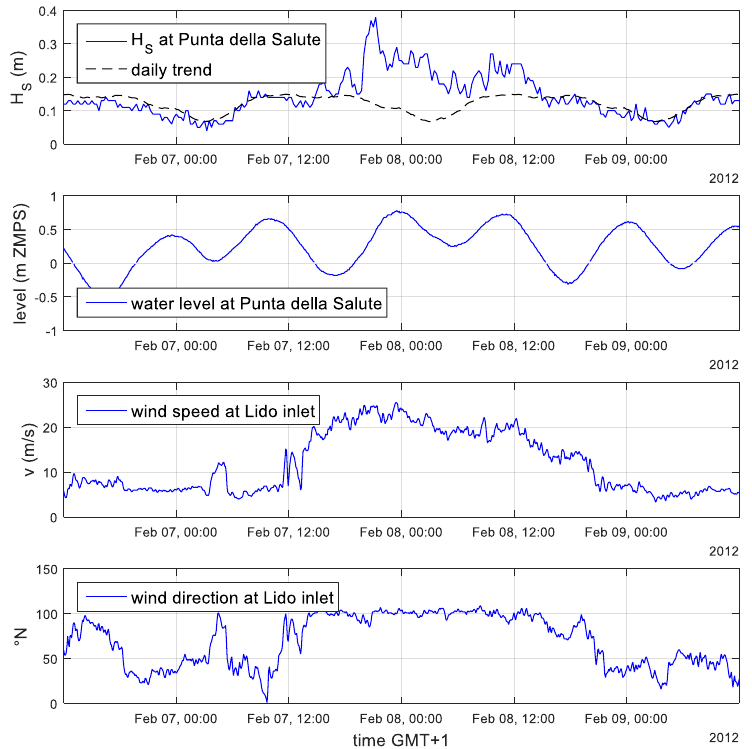
Figure 4. Example of measurements (February 2012), from top to bottom: significant wave height (m), sea level (m ZMPS), wind speed (m/s) and wind direction (°N).